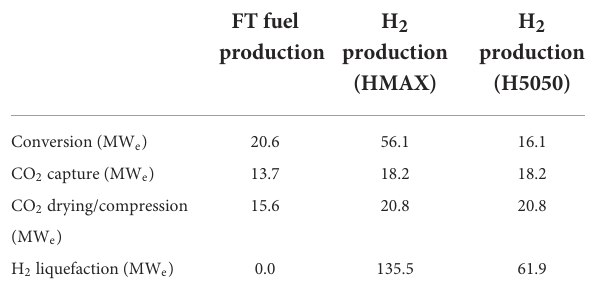
TABLE 5 Power demand for Case 2, based on data from Larson et al. (2009) and equations from Baker et al.